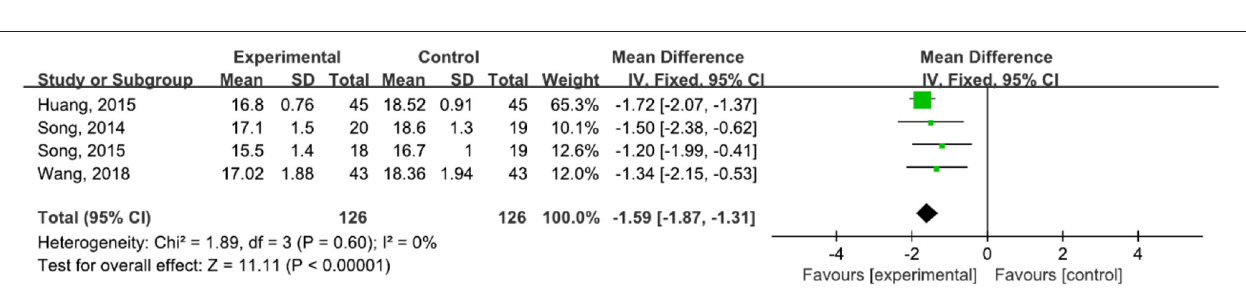
FIGURE 11 | Forest plot showing MD (with 95% CI) for UPDRS-III of the included studies comparing the experimental and control groups.